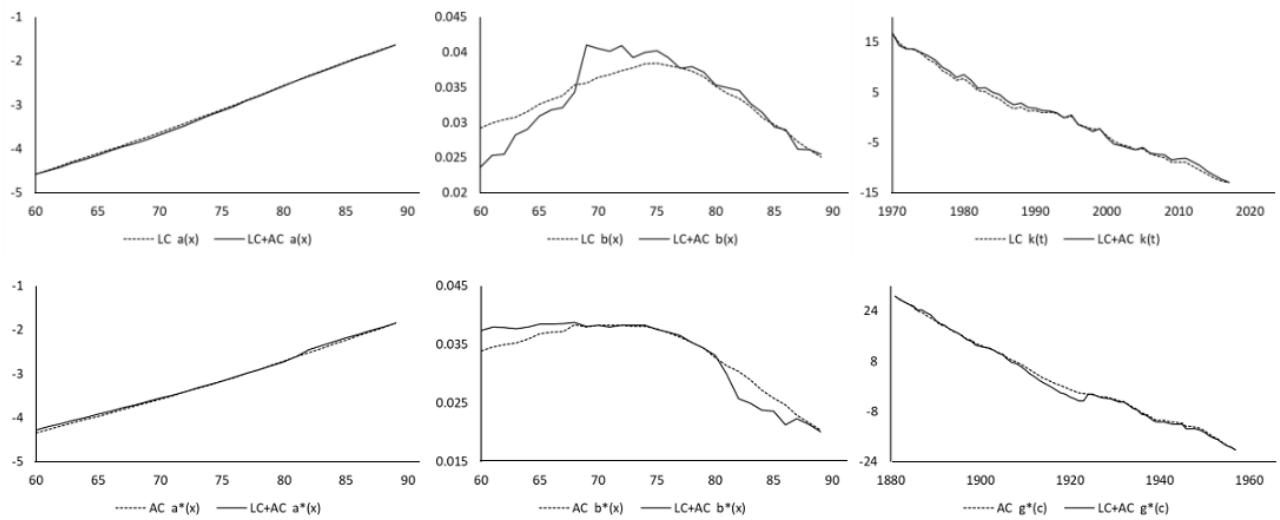
Figure 5. Posterior means of α ( x ) , β ( x ) , κ ( t ) , α ∗ ( x ) , β ∗ ( x ) , and γ ∗ ( c ) from Bayesian Lee–Carter model (alone), age-cohort model (alone), and mixture model.